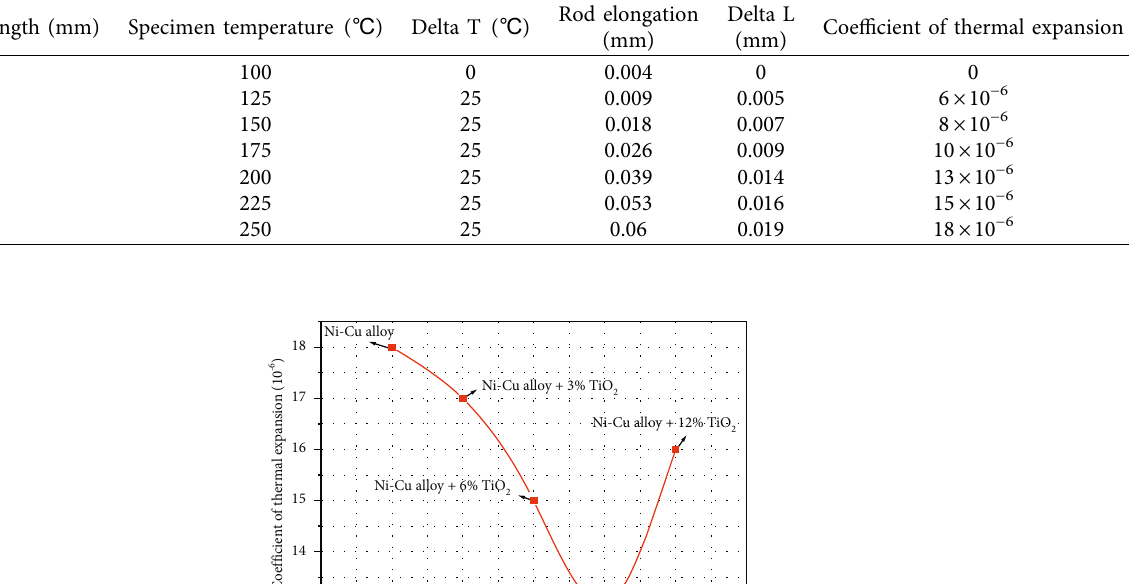
Table 9: CTE of the Ni-Cu alloy (unreinforced) composite.